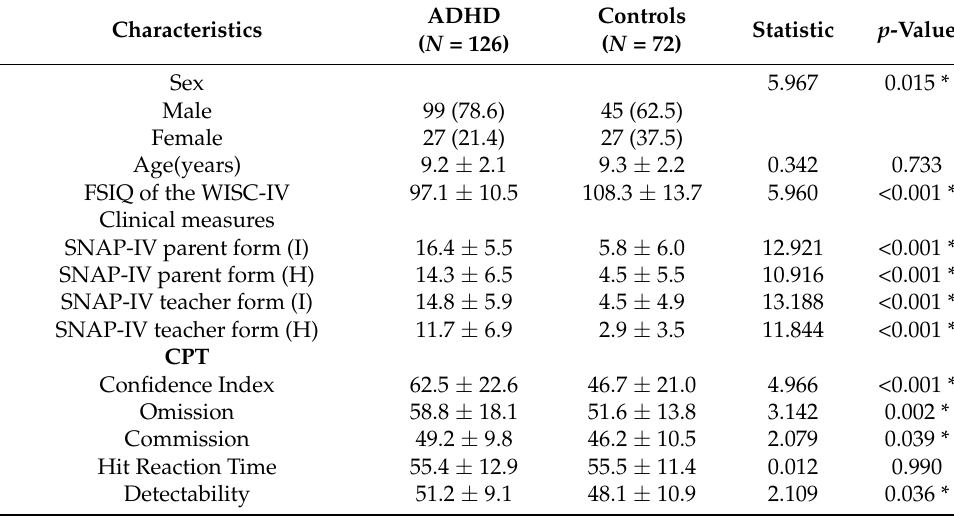
Table 1. Characteristics of Patients with ADHD and Healthy Controls.